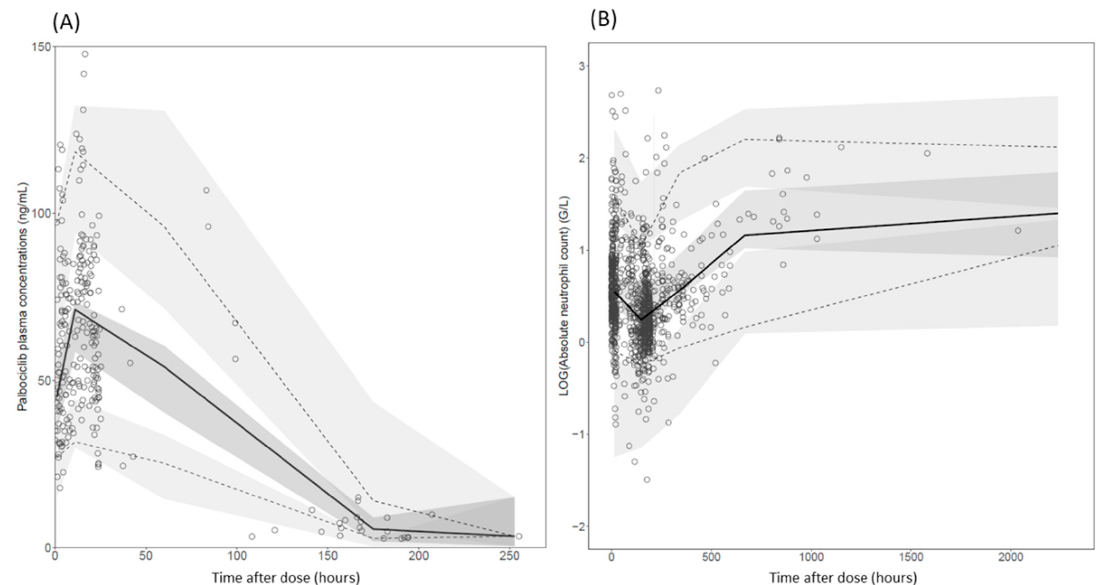
Figure 2. pc-VPC for the final PK-only ( A ) and the final PK/PD model ( B ). Open circles represent palbociclib plasma concentrations ( A ) and log transformed ANC ( B ). The continuous line shows the median observed values, and the dashed lines represent the observed 5% and 95% percentiles. Shaded areas show the model-based 95% confidence interval for the median and the percentiles.